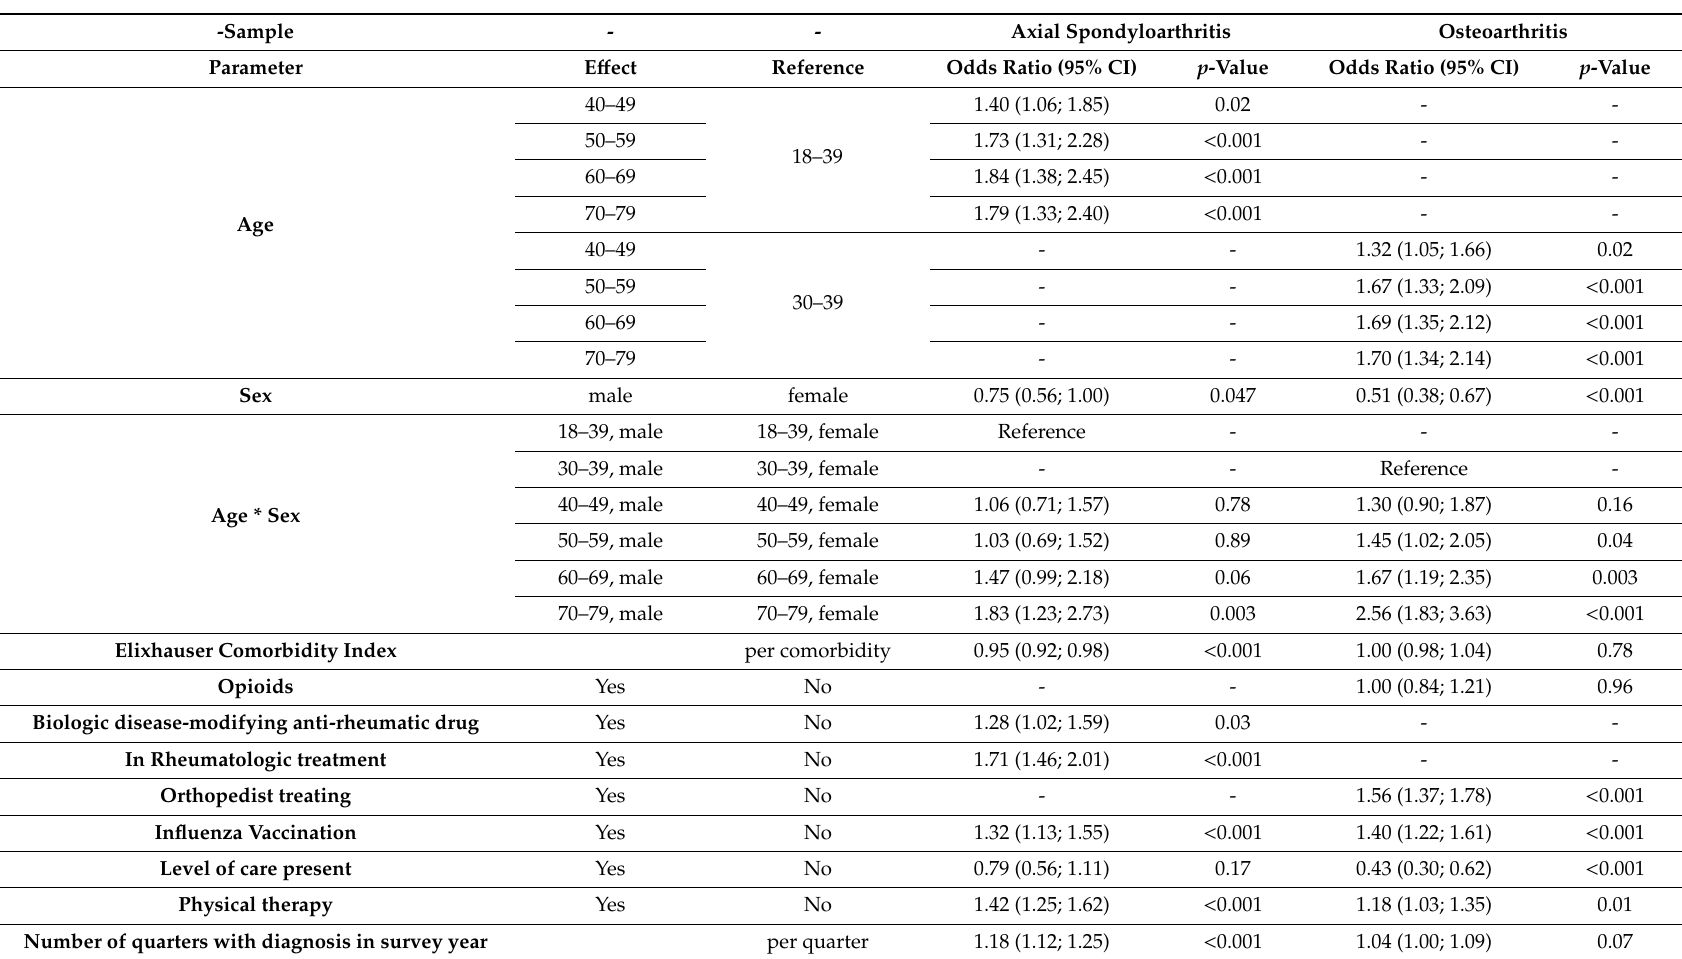
Table 2. Results of one multiple regression model with response as the outcome for each sample. Selected e ff ects of the age and sex interaction are